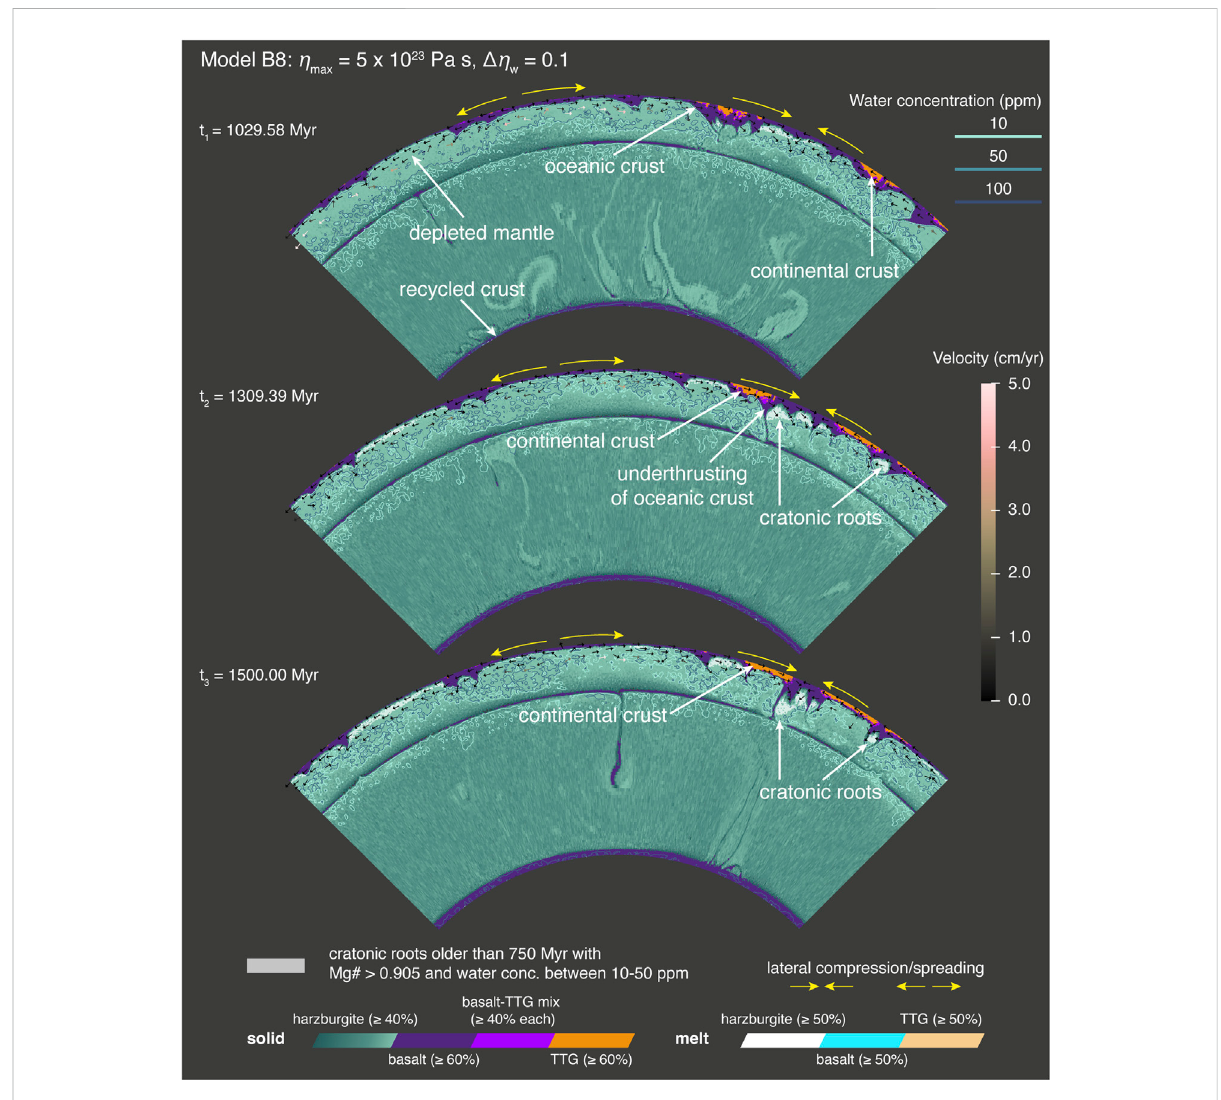
FIGURE 3 CompositionalevolutionwithtimeofsimulationB8initslaterstagesshowingtheformationofcratonicroots(greyshadedregions).Superimposedarethe contoursforwaterconcentrationandvelocityarrowsinthelithosphere.ThereaderisreferredtoFigure2captionforexplanationofdifferentcomposition fi